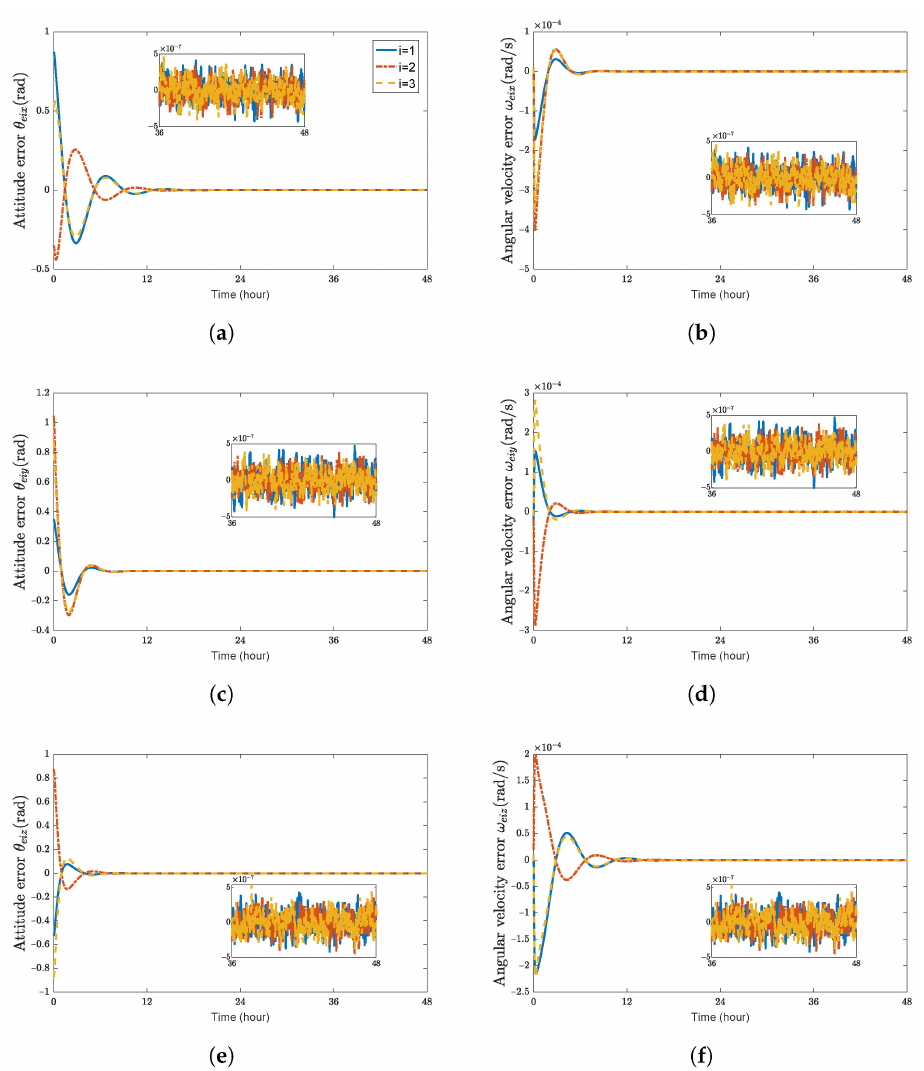
Figure 5. Attitude errors and angular velocity errors of spacecraft SC1 ∼ 3 with adaptive control